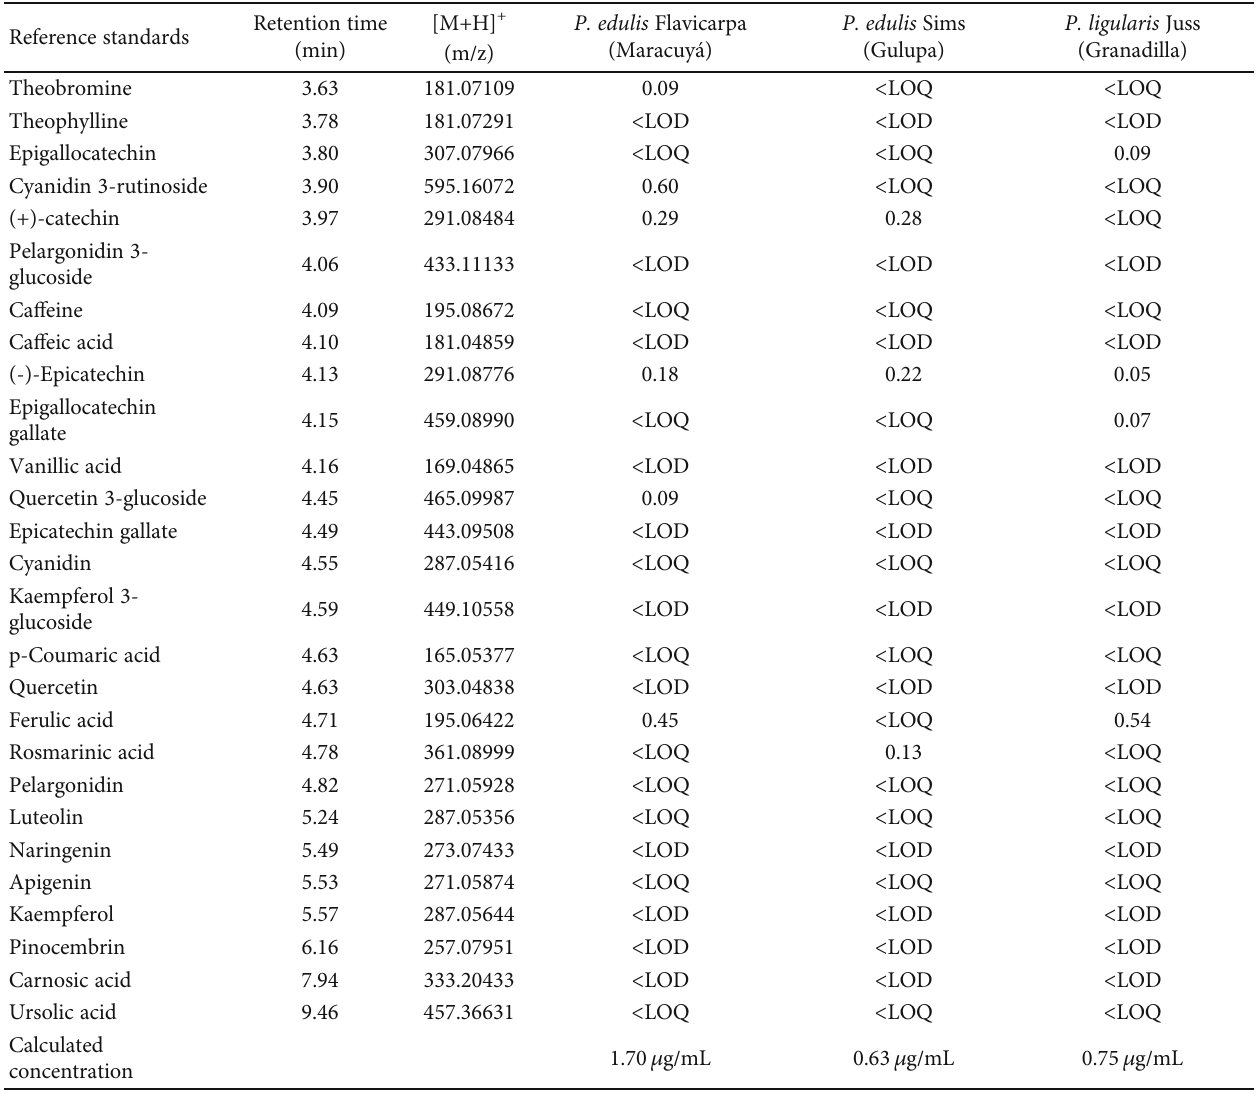
Table 1: Standard reference compounds analyzed by UHPLC/MS and calculated polyphenol concentration in the three Passi fl ora acetone (70%) extracts. Compound found in extracts. LOQ, limit of quantitation 0.05 μ g/mL. LOD, limit of detection, concentrations below 0.02 μ